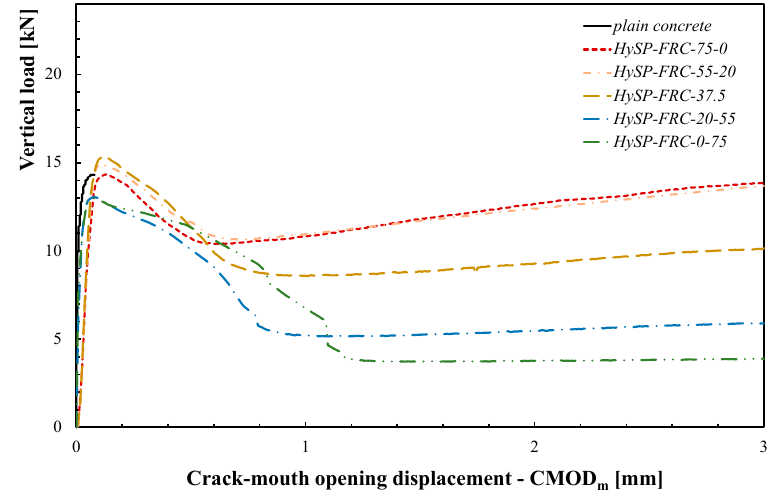
Figure 5. Mean vertical load–mean crack mouth opening displacement (CMOD m ) curves for HySP- FRCs.